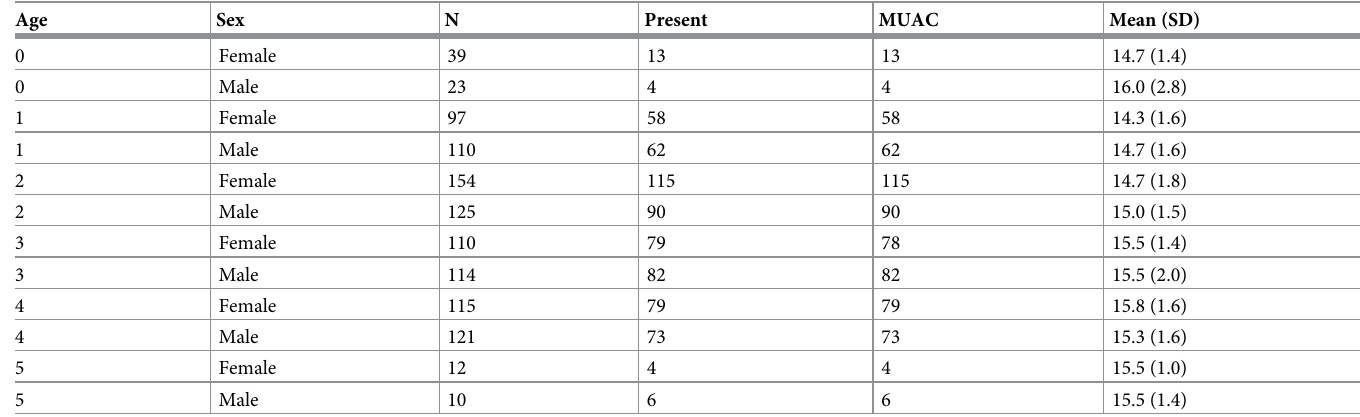
Table 4. Descriptive statistics for MUAC measurements compared to WHO standards for children aged 3–60 months, stratified by age (in years) and sex..